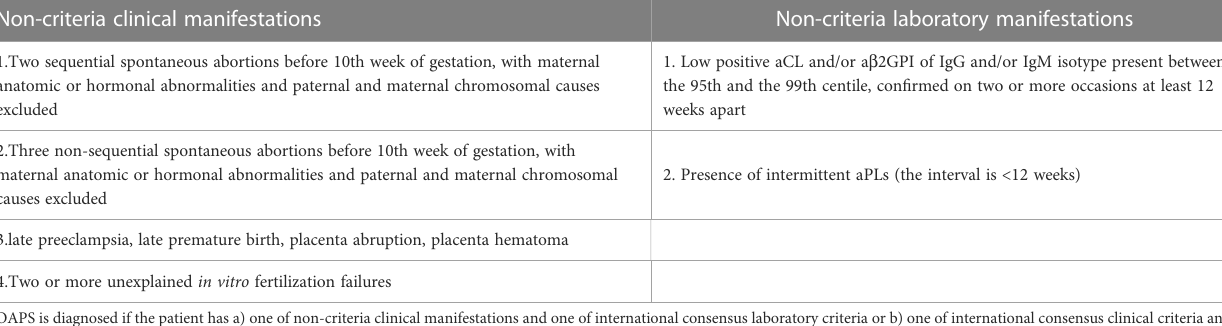
TABLE 1B The diagnostic criteria for